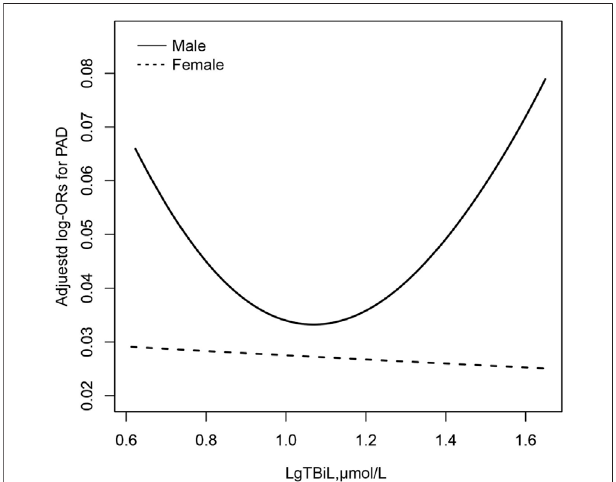
FIGURE 1 | Association between LgTBil and the prevalence of PAD. A nonlinear association between TBil and the prevalence of PAD was found ( p < 0.05). The solid line and dashed line represent the estimated values and their corresponding 95% con fi dence interval. Adjustment factors included sex, age, BMI, SBP, DBP; smoking status, drinking status, diabetes mellitus, stroke,CHD,Hcy,FPG,TG,LDL-C,AST,ALT,eGFR,antihypertensivedrugs, glucose-lowering drugs, lipid-lowering drugs.